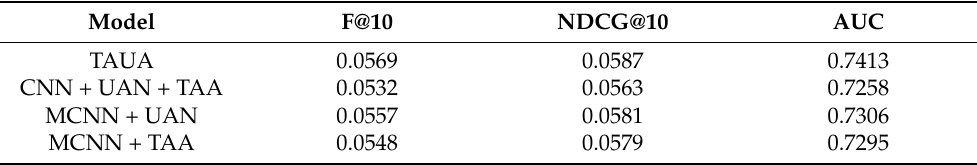
Table 11. Performance ablation of TAUA in Amazon dataset.